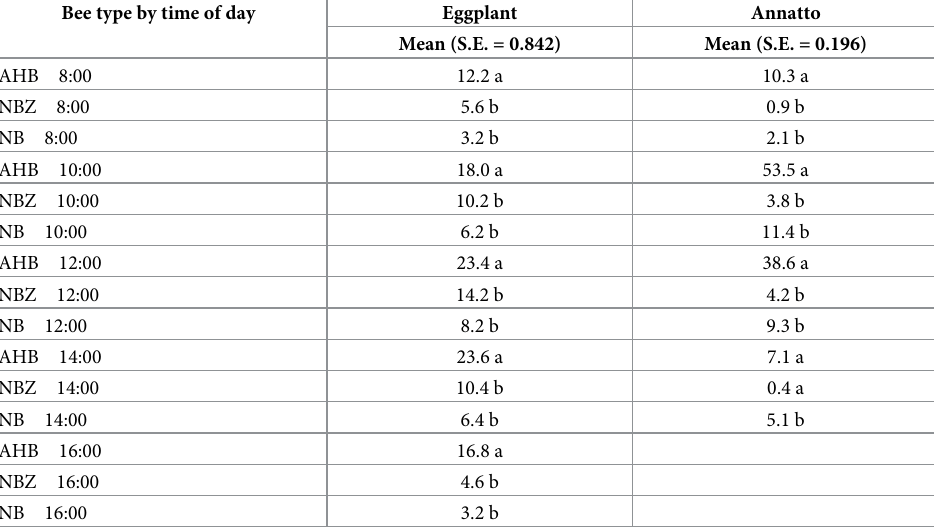
Table 1. Comparison of the average number of honey bees (AHB), native non-sonicating bees (NB) and native sonicating bees (NBZ) visiting flowers of eggplant and annatto in Yucata´n, Me´xico. Different letters within a time of day indicate significant differences at p <